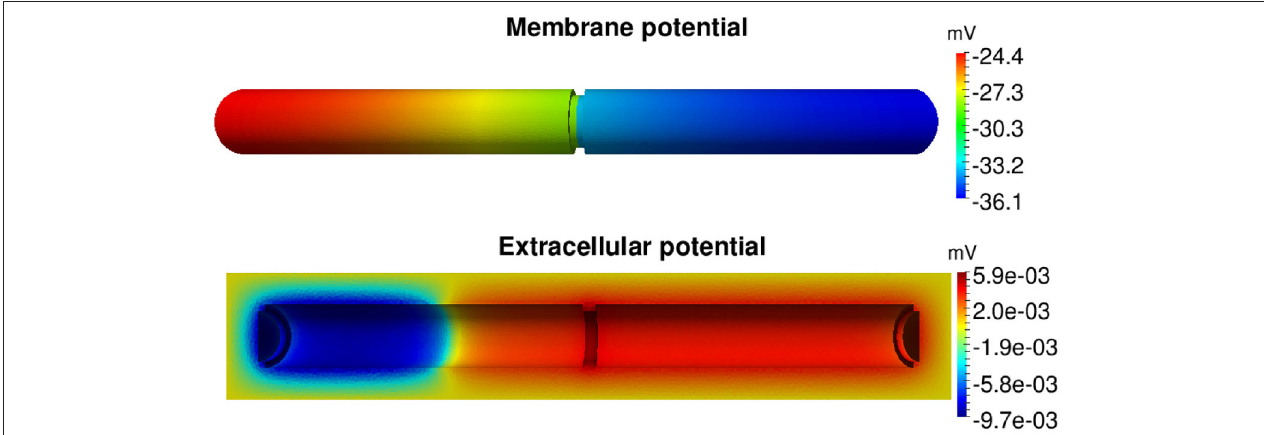
FIGURE 6 | Membrane potential and the surrounding extracellular potential of two connected cylinders at time t = 1 ms computed by the H(div) FEM. The parameters used in the simulations are given in Tables 1 , 10 and we apply a stimulus current of 120 µ A/ µ F for the first half of the first cell in the x direction.